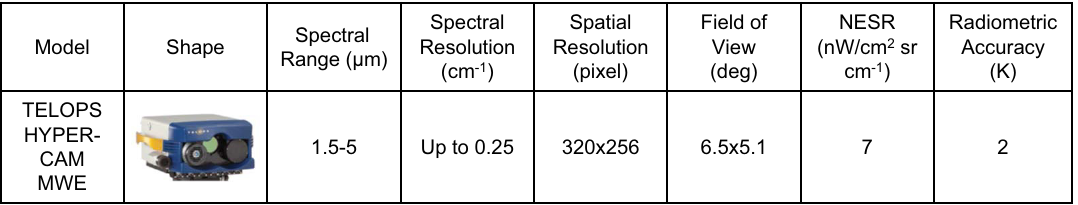
Figure 9. Specifications of the TELOPS Hyper-Cam MWE sensor.